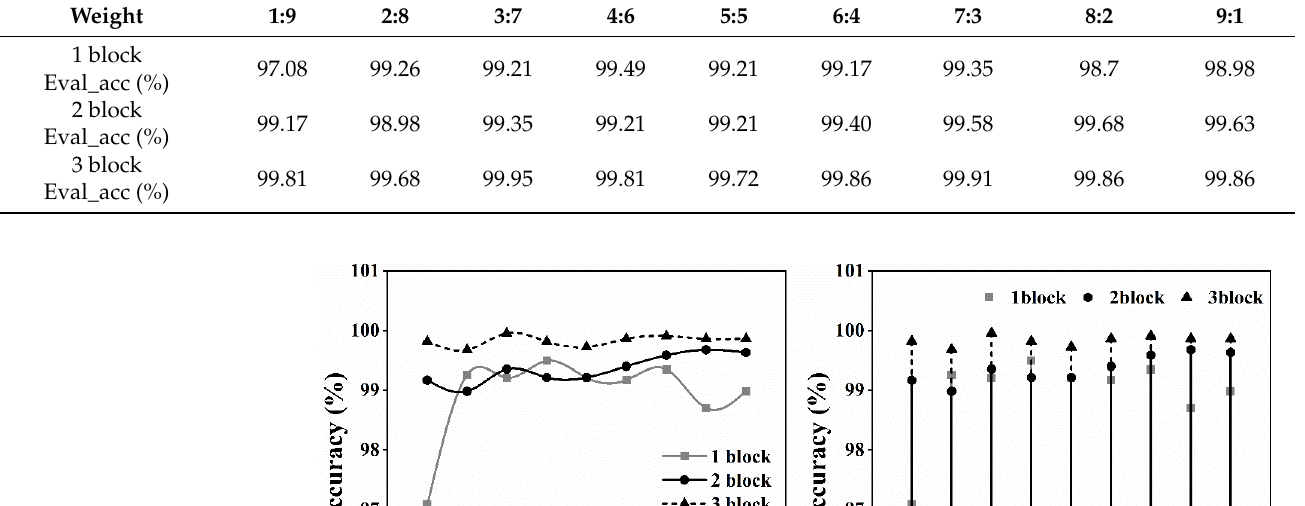
Table 7. Experimental results under different evaluation indexes.